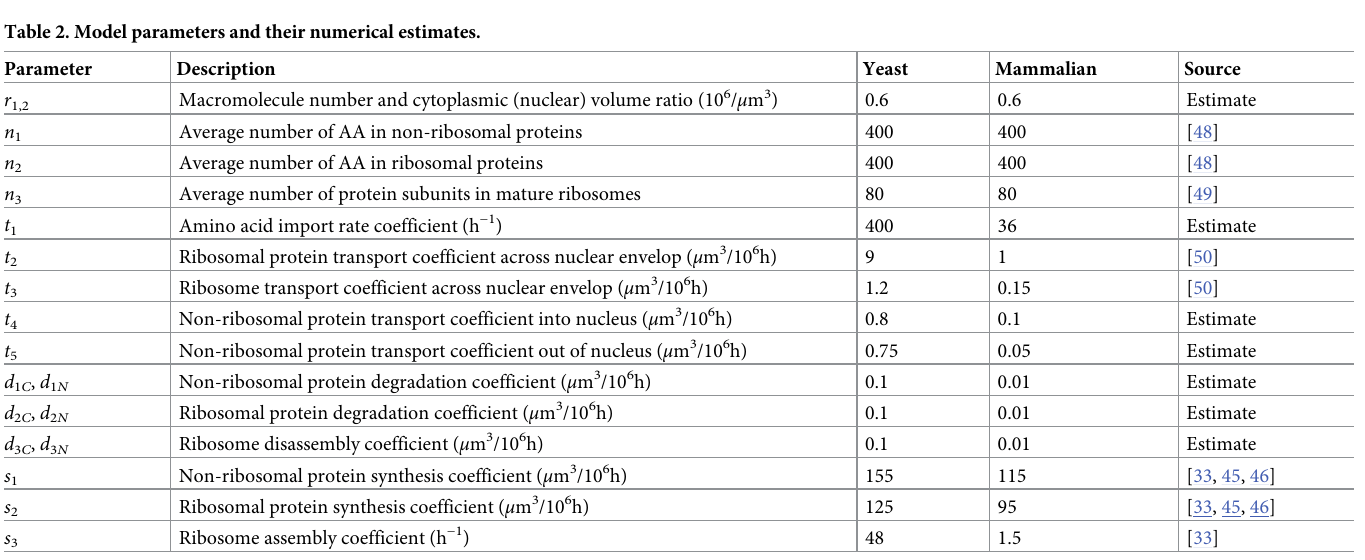
Table 2. Model parameters and their numerical estimates. Parameter Description Yeast Mammalian